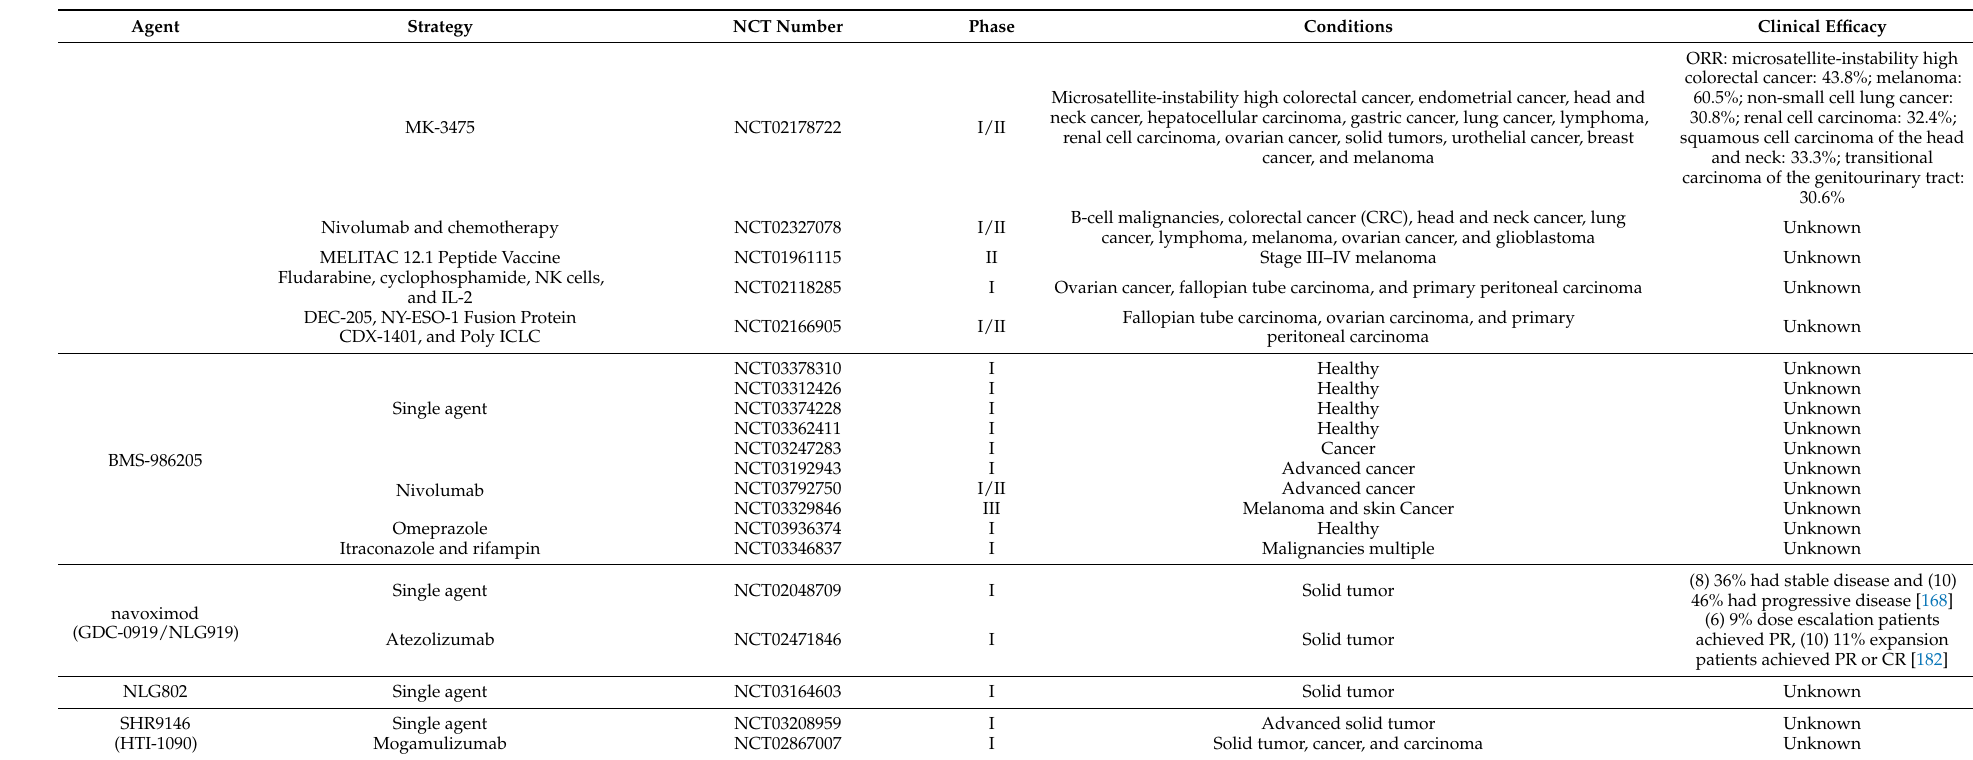
renal cell carcinoma, ovarian cancer, solid tumors, urothelial cancer, breast cancer, and melanoma